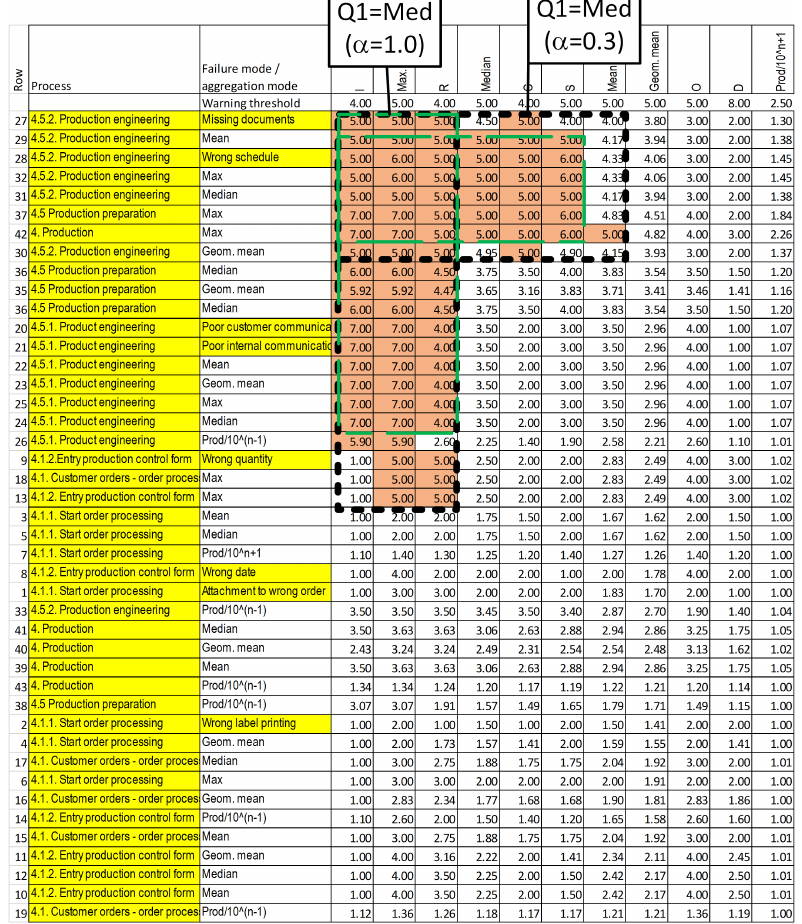
Figure 6. The supervised risk evaluation results. The seriated and biclustered risk-level matrices for different risk events are